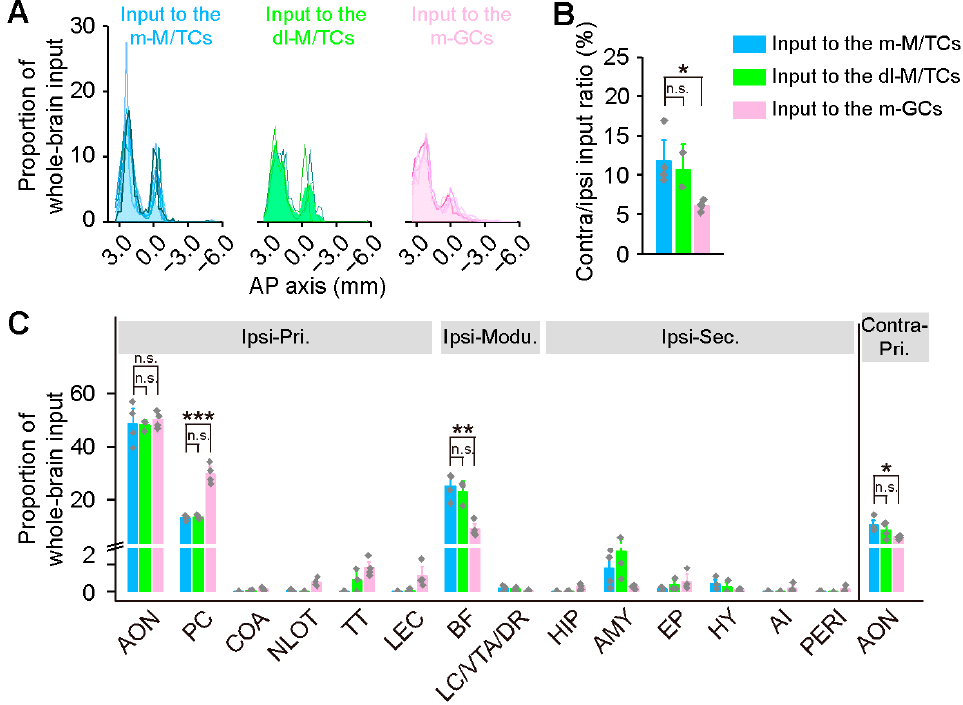
Figure 2. Brain-wide input distribution of the OB. ( A ) Quantified distribution of the input neurons targeting the M/TCs and GCs along the anterior–posterior (AP) axis. Colored lines denote individual animals. ( B ) Relative ratio of the contralateral input to the ipsilateral input. ( C ) Proportion of input neurons in discrete brain regions. Regions that contributed more than 0.1% of the total input are summarized here. Pri., primary olfactory areas; modu., neuromodulatory areas; sec., secondary olfactory areas; AON, anterior olfactory nucleus; PC, piriform cortex; COA, cortical amygdalar nucleus; NLOT, lateral olfactory tract nucleus; TT, taenia tecta; LEC, lateral entorhinal cortex; BF, basal forebrain; LC, locus coeruleus; VTA, ventral tegmental area; DR, dorsal raphe nucleus; HIP, hippocampal region; AMY, amygdalar area; EP, endopiriform nucleus; HY, hypothalamus; AI, agranular insular cortex; PERI, perirhinal cortex. Data are shown as the mean ± s.e.m.; gray rhombuses denote individual animals in ( B , C ). Dorsolateral M/TC: n = 3 animals; medial M/TC and medial GC: n = 4 animals per group. Unpaired two-tailed t -tests were used for ( B , C ). * p < 0.05, ** p < 0.01, *** p < 0.001, n.s. no significant